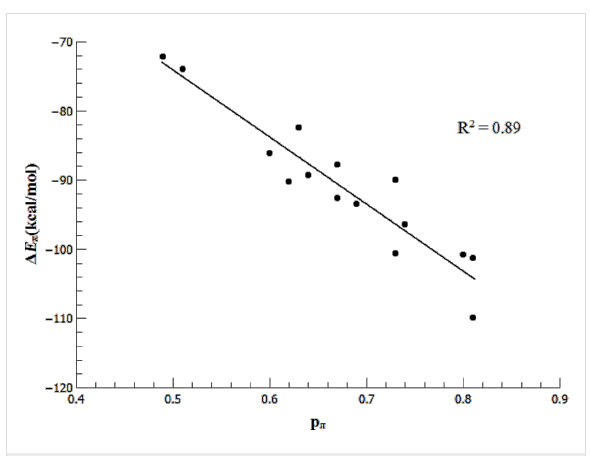
Figure 3: Plot of deformation densities ∆ρ of the pairwise orbital interactions between C( 3 P) and N(Me)HC=CHN(Me), associated energies ∆ E in kcal/mol. The color-code of the charge flow is red → blue.